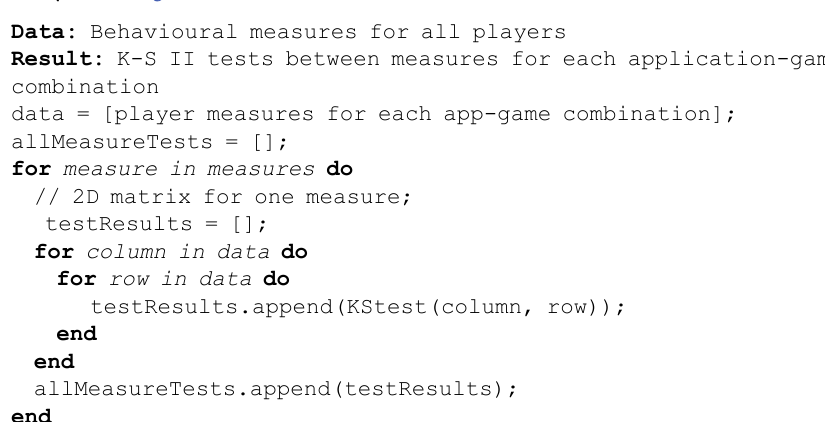
Algorithm 1: Two sample Kolmogorov-Smirnov tests for each behavioural measure